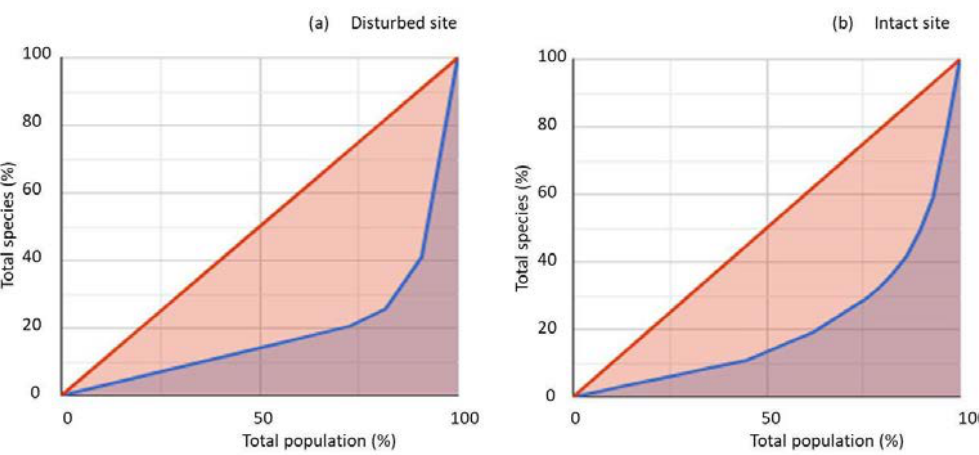
Fig. 6: Lorenz graphs of fish species at disturbed (a) and intact (b) sites on West Java coast